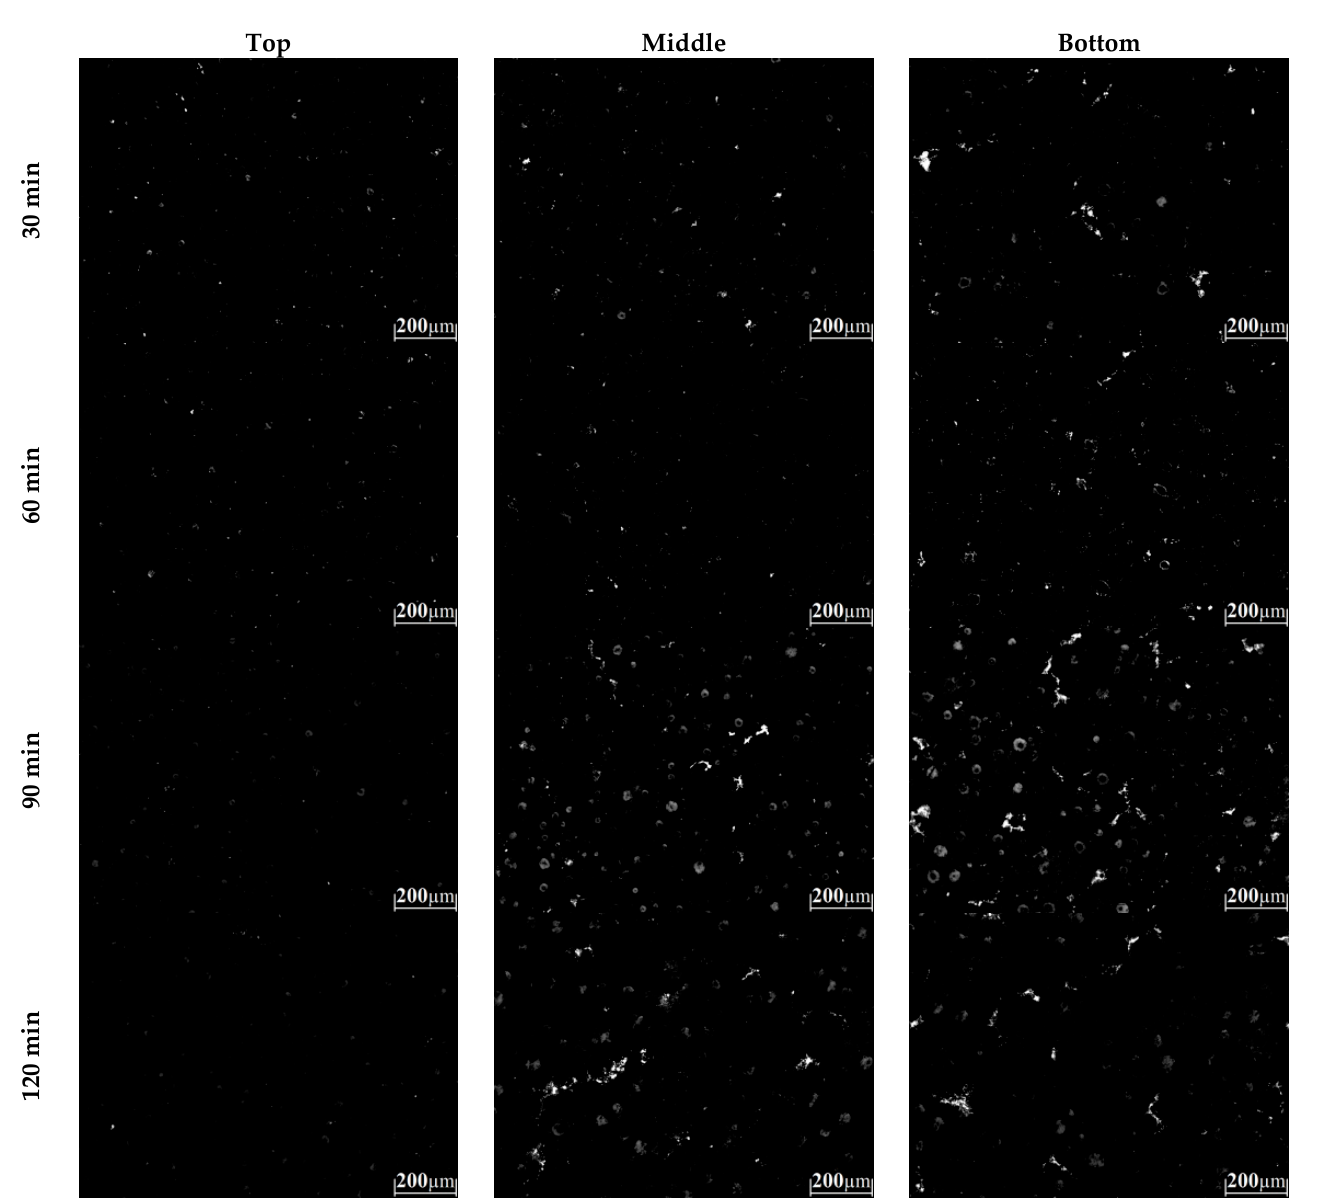
Figure 10. Microstructures etched with ammonium persulfate for the ADIs alloyed with 0.2 and 0.3% V heat-treated at 265 and 305 °C for 90 min and the three regions analyzed of the lobe.